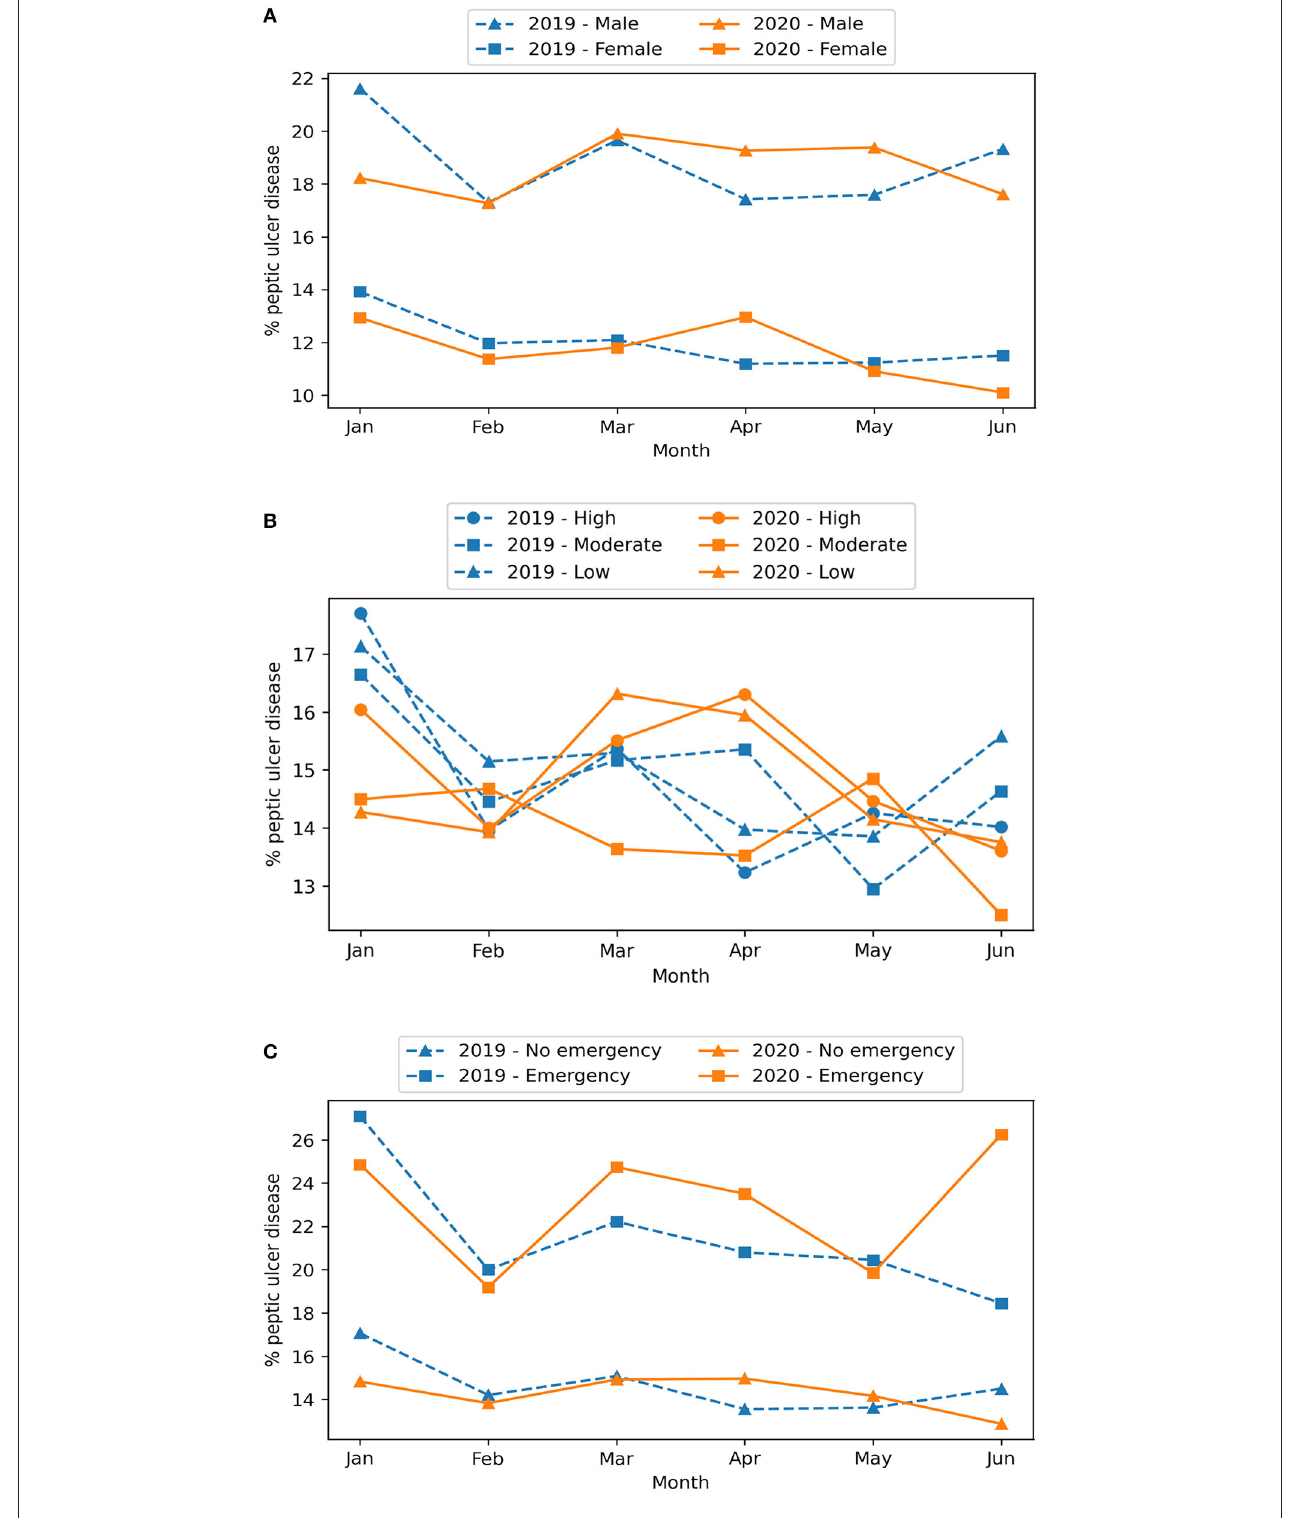
FIGURE 5 | Monthly proportion of PUD between 2019 and 2020 by sex (A) , COVID-19 risk of the residential area (B) , and GI emergency endoscopy (C) .